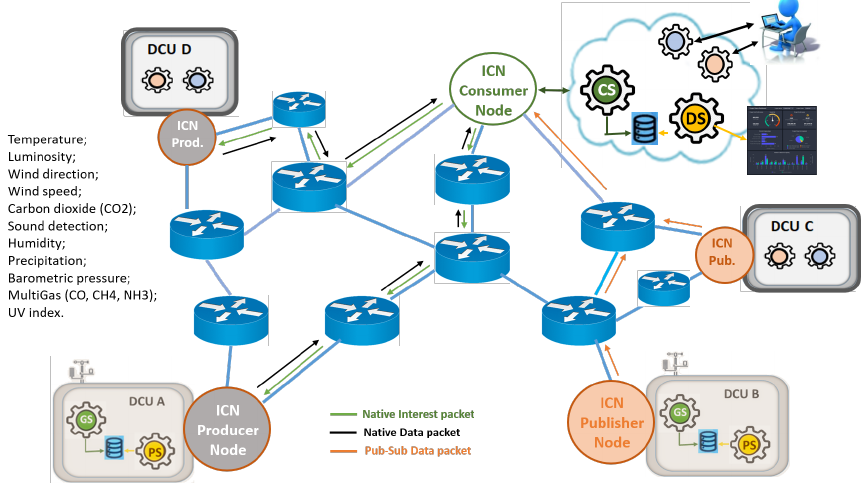
Figure 9. Use case 2: multiples traffic types in the ICN.